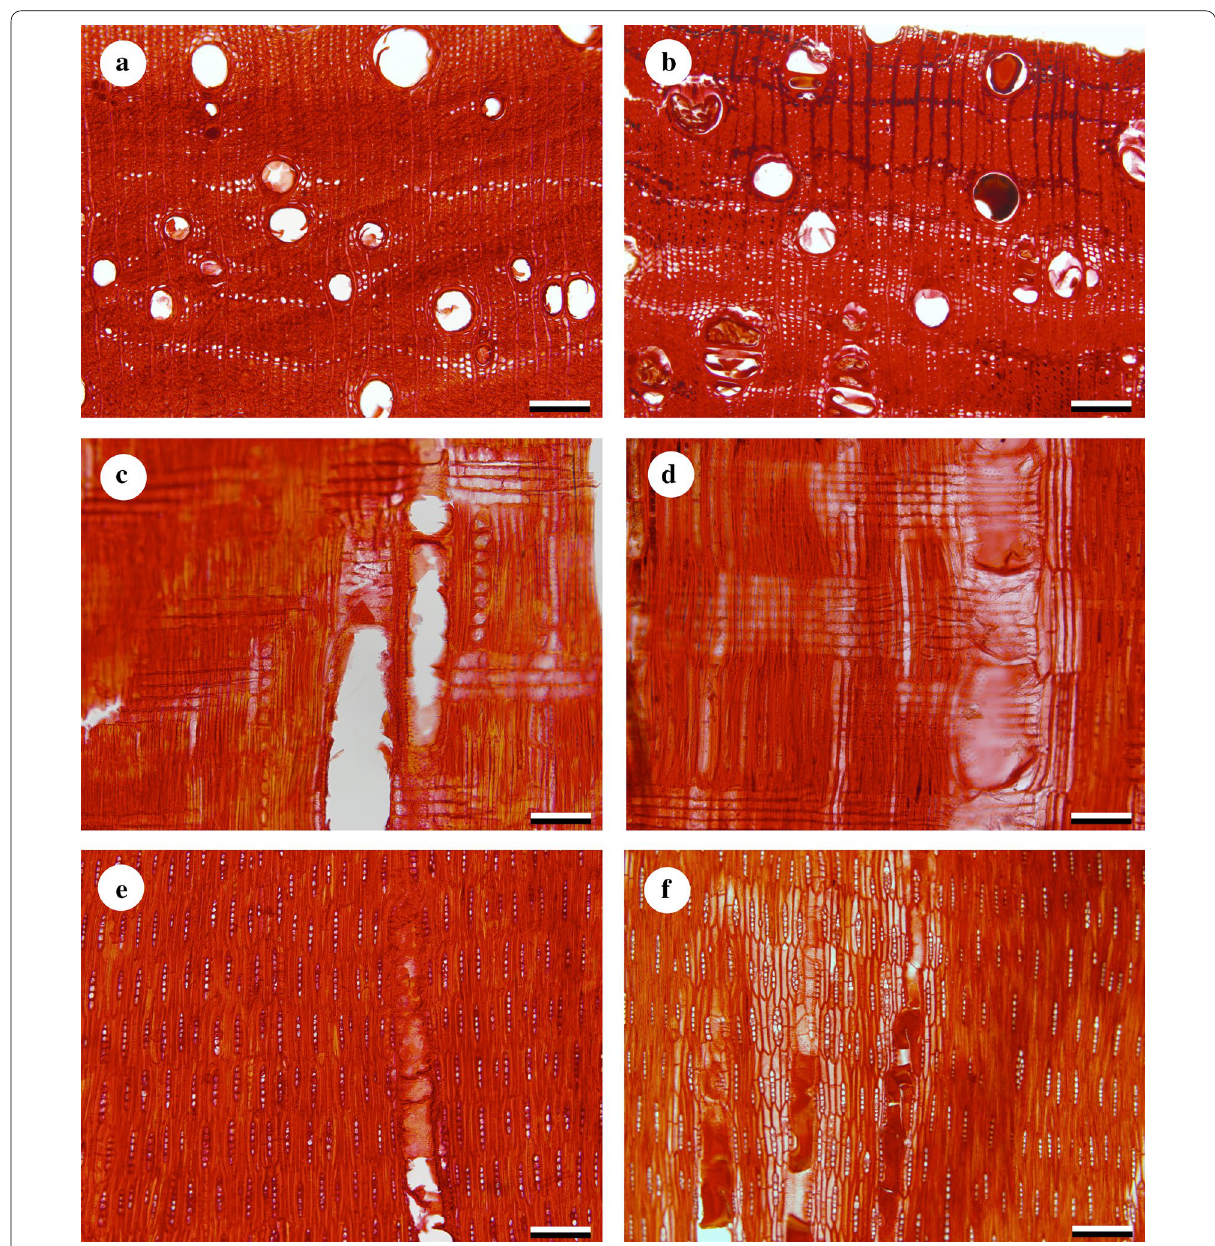
Fig. 1 Light micrographs of transverse, radial and tangential sections of heated Pterocarpus santalinus ( a, c, e ) and Pterocarpus tinctorius ( b, d, f ) wood. – Scale bars, 200 μm ( a , b , e , f ), 100 μm ( c , d